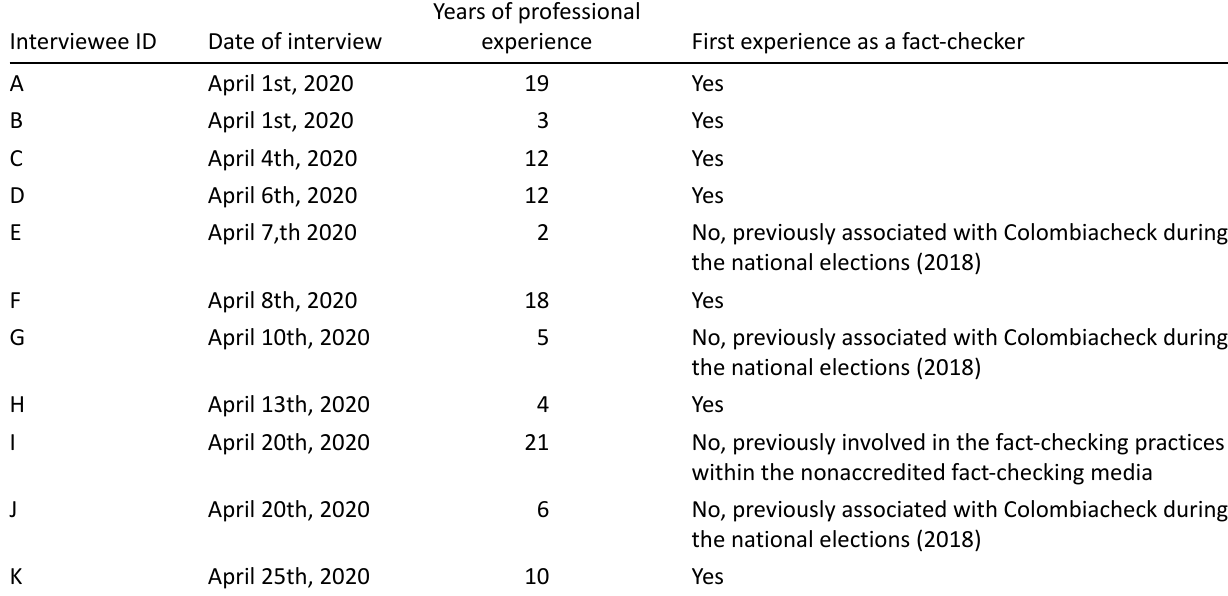
Table 1. List of